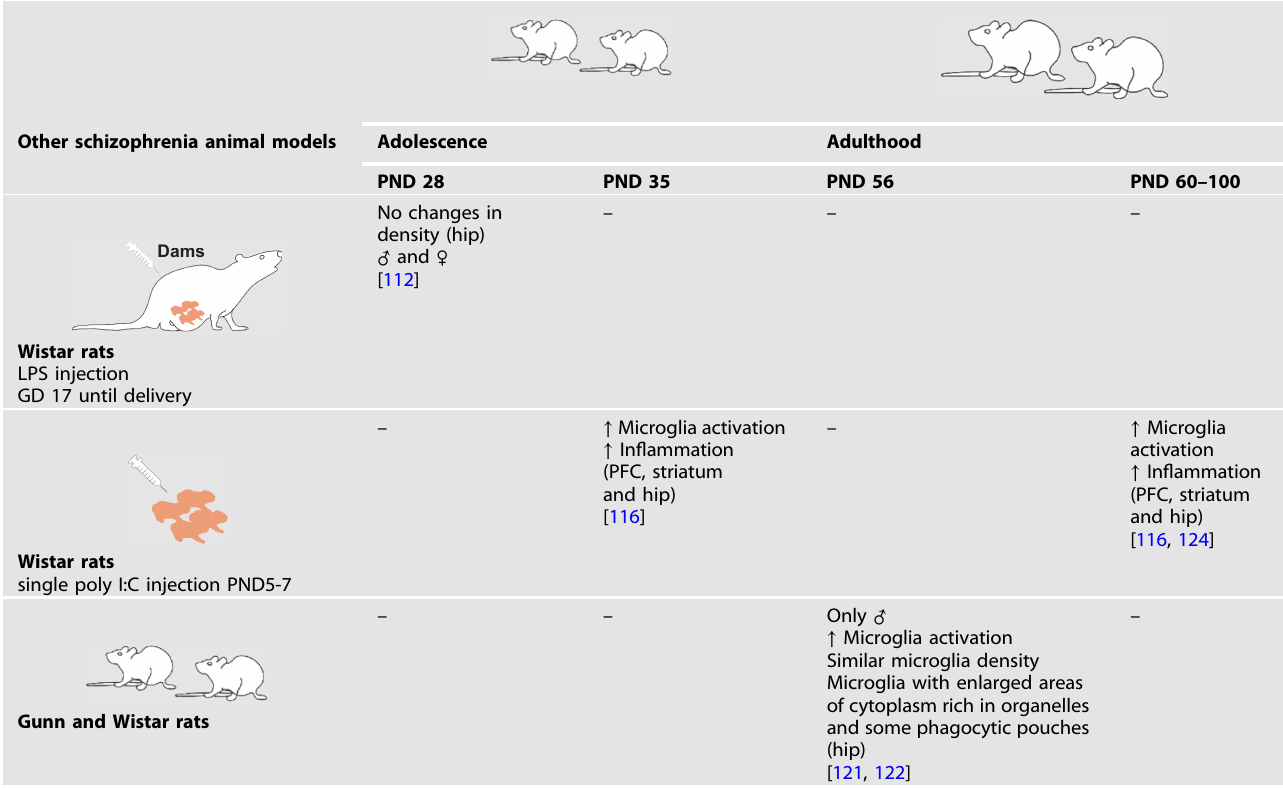
Table 4. Microglia sequelae: evidences from neurodevelopment until adulthood in others schizophrenia animal models.